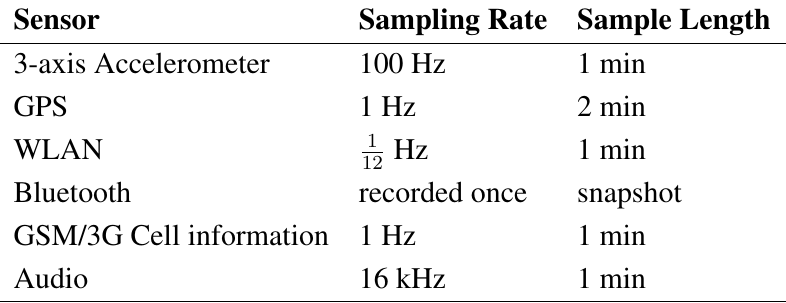
Table 2. Collected